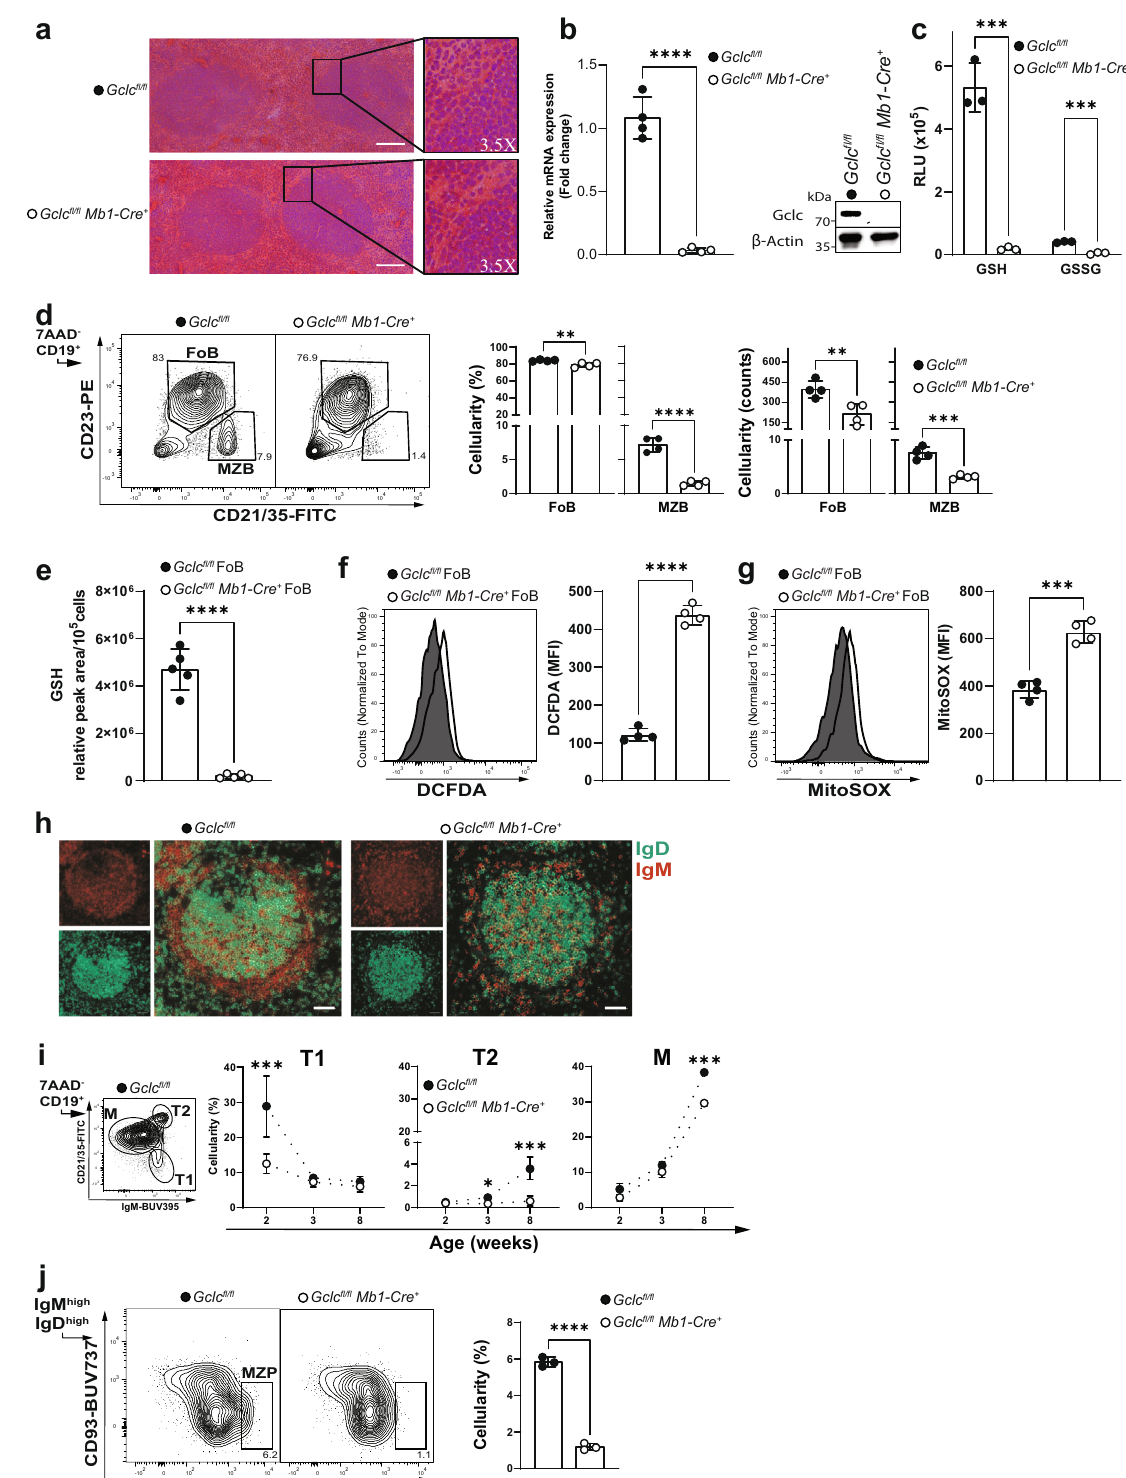
The mTOR pathway confers MZB-like properties to GSH- de fi cient FoB . To investigate further the function of GSH in total splenic B cells, we performed a comparative single-cell CITE-seq analysis on B cells from Gclc fl / fl and Gclc fl / fl Mb1-Cre + mice. tSNE visualization of the total B cell transcriptomic landscape revealed minor changes in the distribution of single-cell transcriptomes